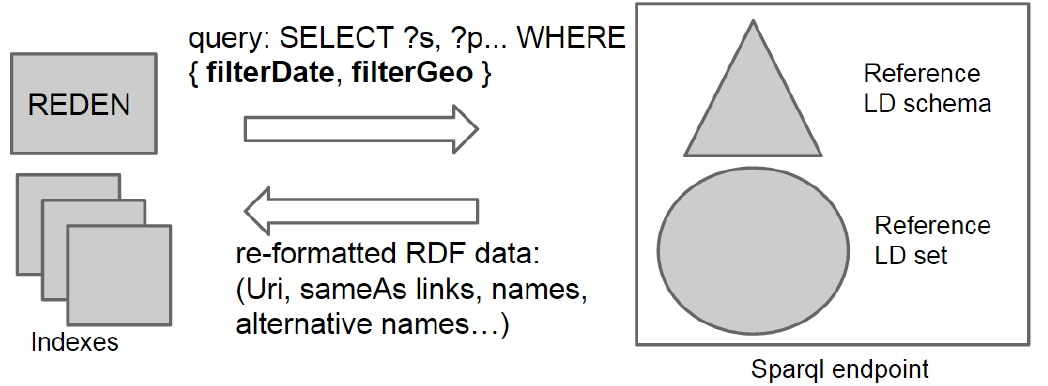
Figure 4. Domain-adapted data extraction performed by REDEN during candidate